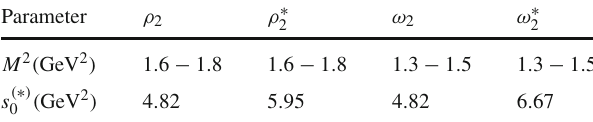
Table 4 Mass values of the axial-tensor mesons at T = 0 and compar- ison of the numerical values with experimental data from “PDG”